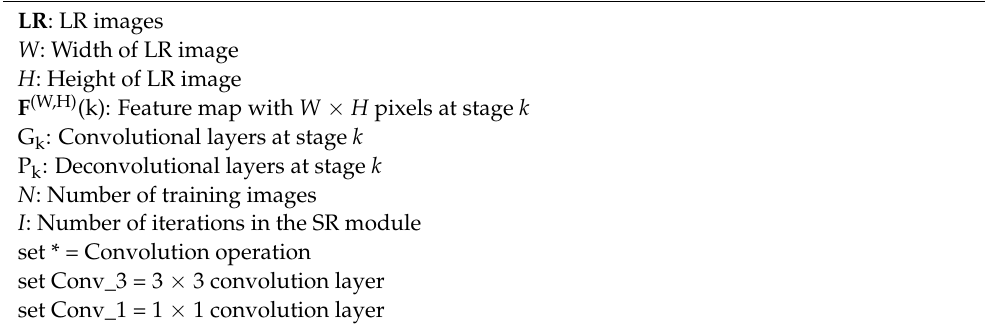
Algorithm 1. The pseudocode of the holistic-feature-extraction-based SR module for scale factor ×